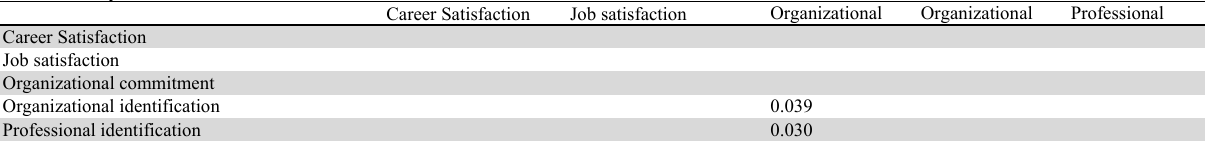
The summary of total Indirect Effects